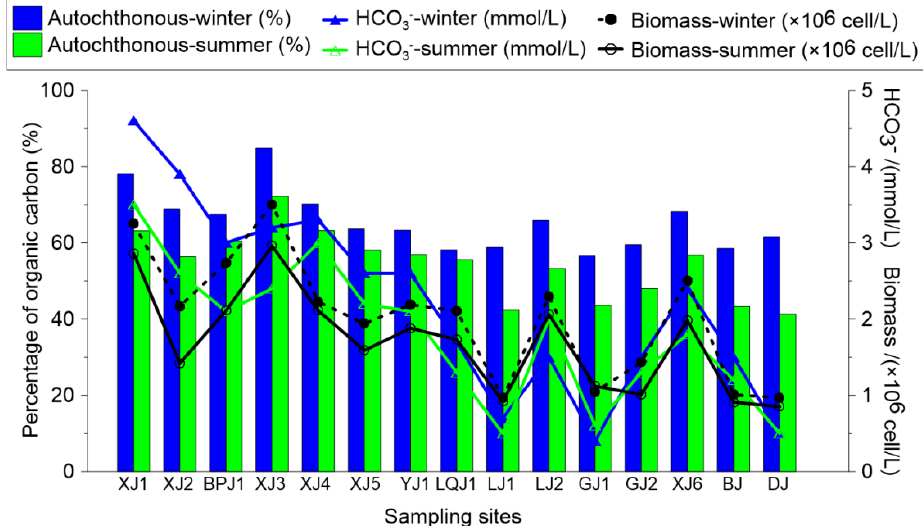
Figure 7. Seasonal and spatial distributions of autochthonous (%) and allochthonous (%) OC and the hydrochemical (HCO 3- ) and biological (C16:1ω/C18:2ω and biomass) parameters; TAR FA = (C24 + C26 + C28)/(C12 + C14 + C16); autochthonous (%) OC = [ Σ SCFA(C12~C18)/TAR FA ] × 100%; and allochthonous (%) OC = [ Σ LCFA(C22~C30)/TAR FA ] × 100%.